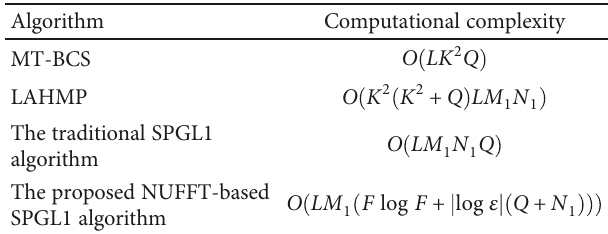
Table 2: Computational complexity of four algorithms.